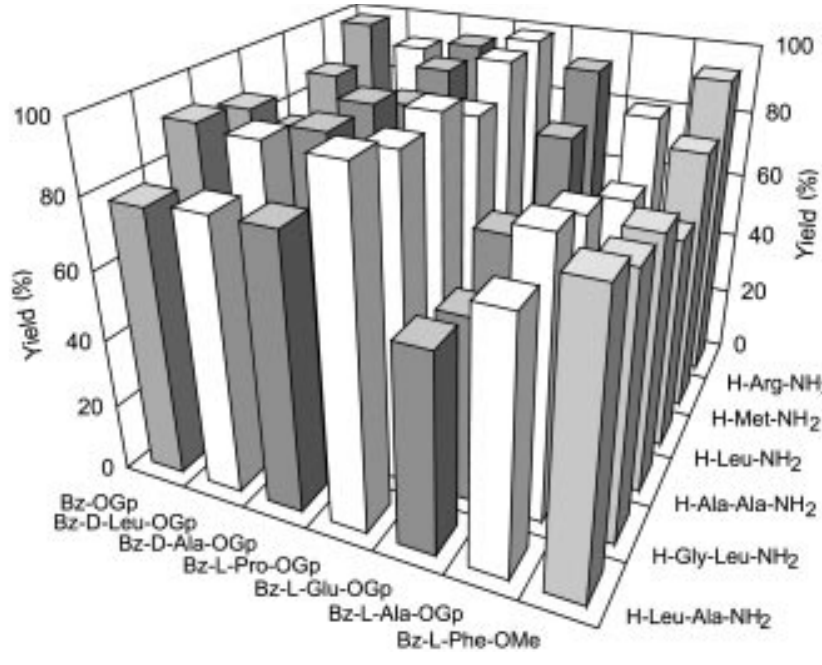
Figure 9 - Yields of chymotryp- sin-catalyzed peptide synthesis using 4-guanidinophenyl esters bearing nonspecific coded and non-coded acyl moieties (Gün- ther R, Thust S, Hofmann H-J and Bordusa F, unpublished re- sults). Conditions: 0.2 M HEPES- buffer, pH 8.0, 0.2 M NaCl, 20 mM CaCl 2 , 25 o C, 10% MeOH; [acyl donor]: 2 mM, [acyl accep- tor]: 20 mM, [enzyme]: 0.1-37 µM; all errors are less than